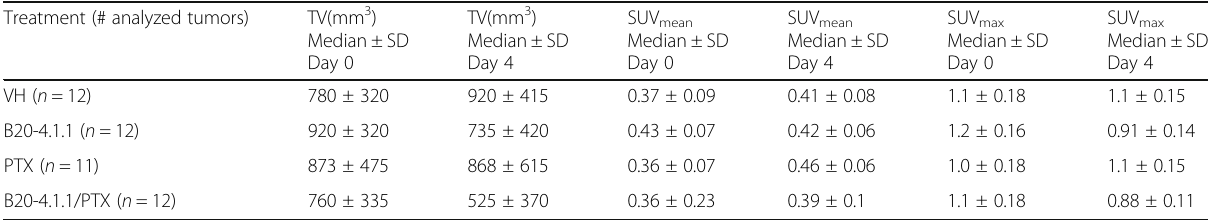
Table 1 The tumor volumes (TV) and ( R )-[ 11 C]PAQ SUV values at baseline (day 0) and at treatment follow-up (day 4) Treatment (# analyzed